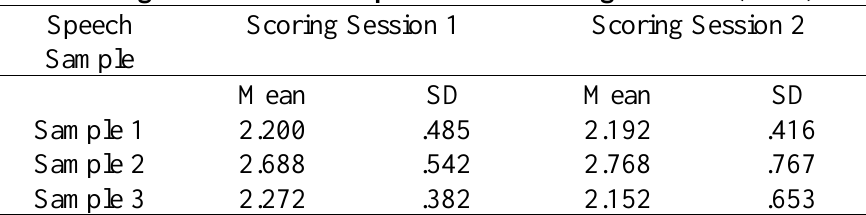
Scoring results for the experimental scoring sessions